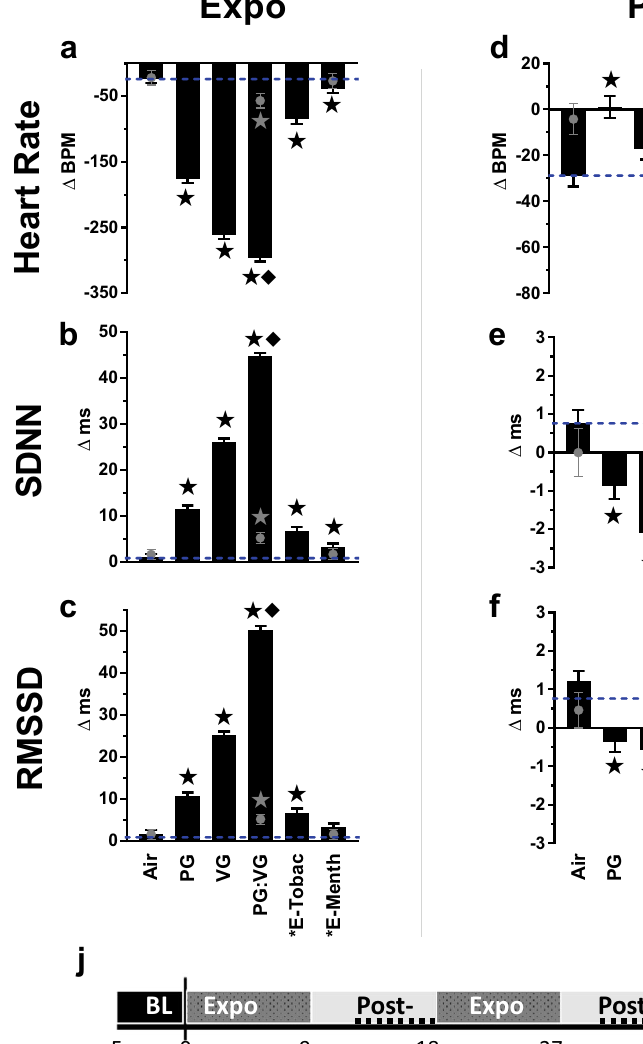
diamond) in mixed model analyses. Asterisk indicates nicotine present. “ E-Tobac ” and “ E-Menth ” denote E-Tobacco ( n =4) and E-Menthol ( n =7) among males. For Air, PG, VG, and PG:VG, n =8 among males. For females, n =4 per treatment. For averages of individual subjects by phase, and simple means and standard errors, see Supplementary Fig. 5. Source data, including all p values, are provided as a Source Data fi